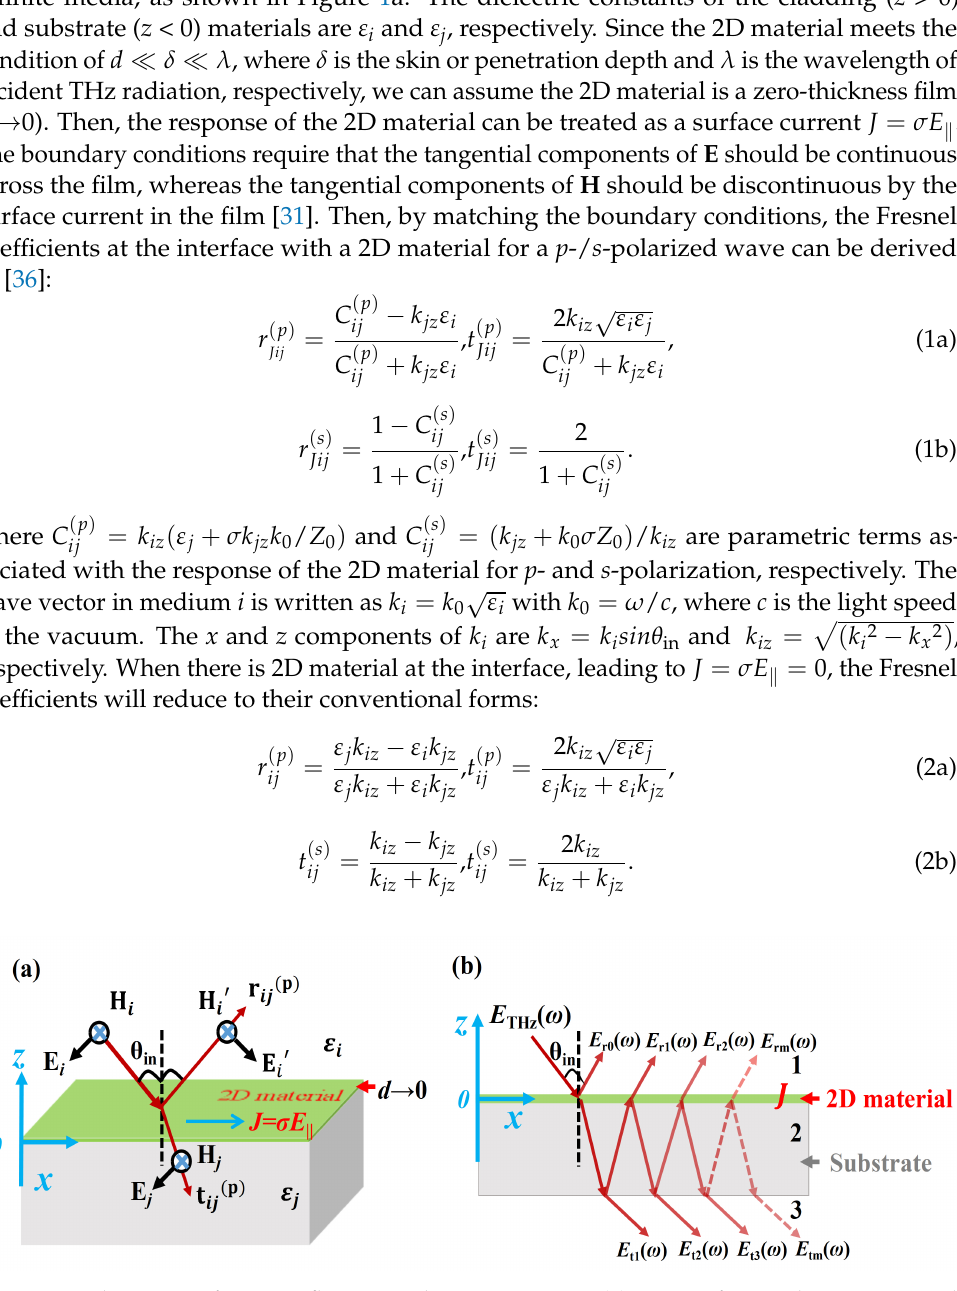
Figure 1. Schematics of wave reflection and transmission at ( a ) an interface with a 2D material between two semi-infinite media and ( b ) a 2D material/substrate system. In ( a ), p -polarized wave is taking as an example. Note that E THz ( ω ) is the electric field of the incident THz wave, E tm ( ω ) is the electric field of the m -th-order transmitted wave while E rm ( ω ) denotes the electric field of the m -th-order reflected wave. Medium 1, 2, and 3 are air, dielectric substrate, and air, respectively. Note that the surface current is represented by a blue arrow in ( a